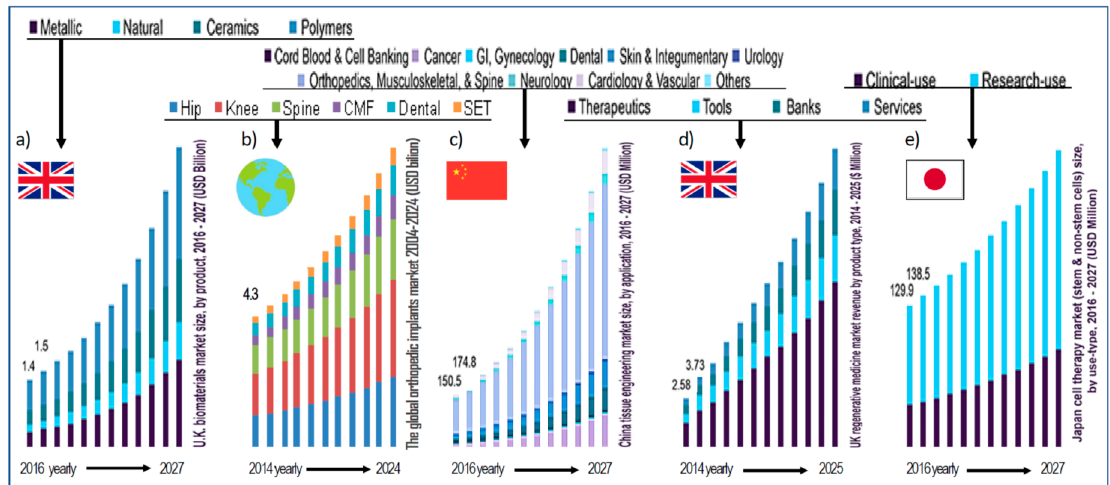
Figure 36. The structure of global markets due to ( a ) the use of biomaterials for the treatment of various diseases; ( b ) involvement of individual geographic regions in tissue engineering technologies; ( c ) the suitability of regenerative medicine methods for treat- ing multiple diseases; ( d ) the contribution of allogeneic and autologous cell-mediated therapies.